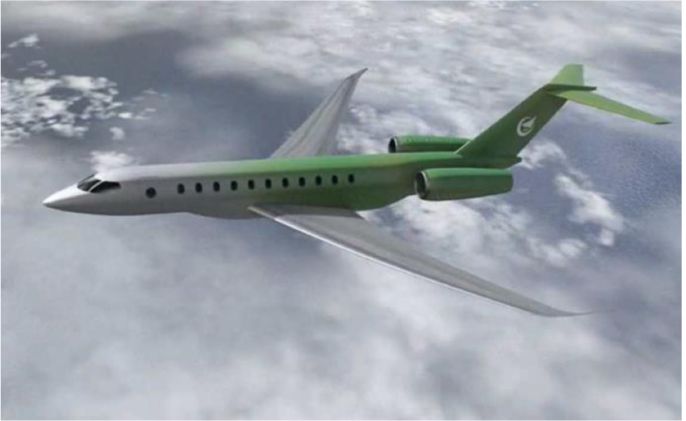
Figure 1. Artist impression of the long-haul business jet concept with cruise Mach number of 0.87